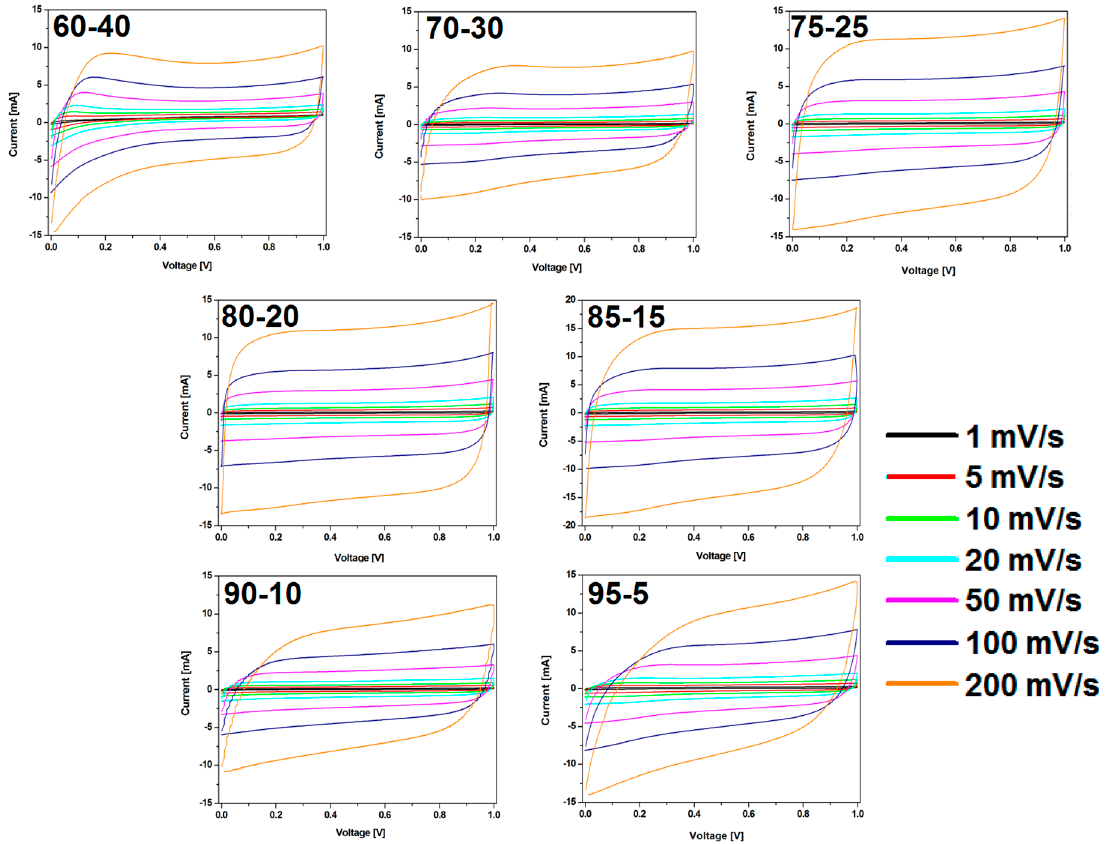
Figure 8. The CV curves of the electrodes prepared by evaporation with different ratios of CMOF-5:PVDF.